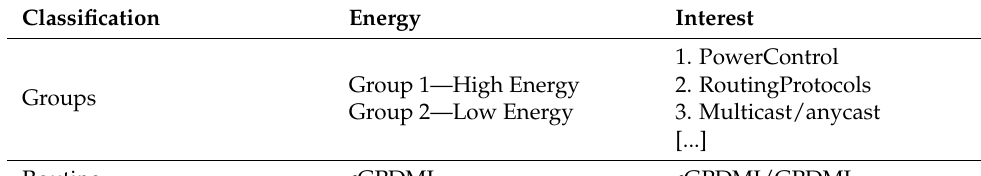
Table 7. Classification used for the formation of energy and interest groups.